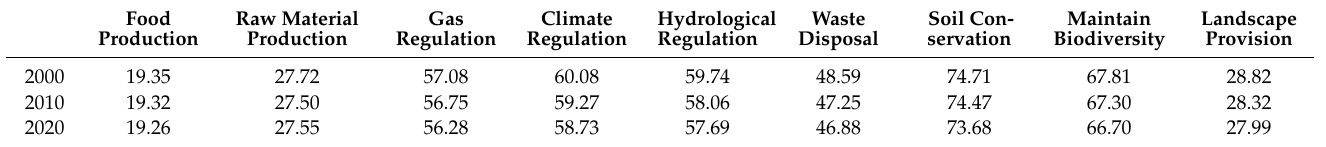
Table 4. The individual ESV in the Loess Plateau of Northern Shaanxi. Unit: CNY 100 million.